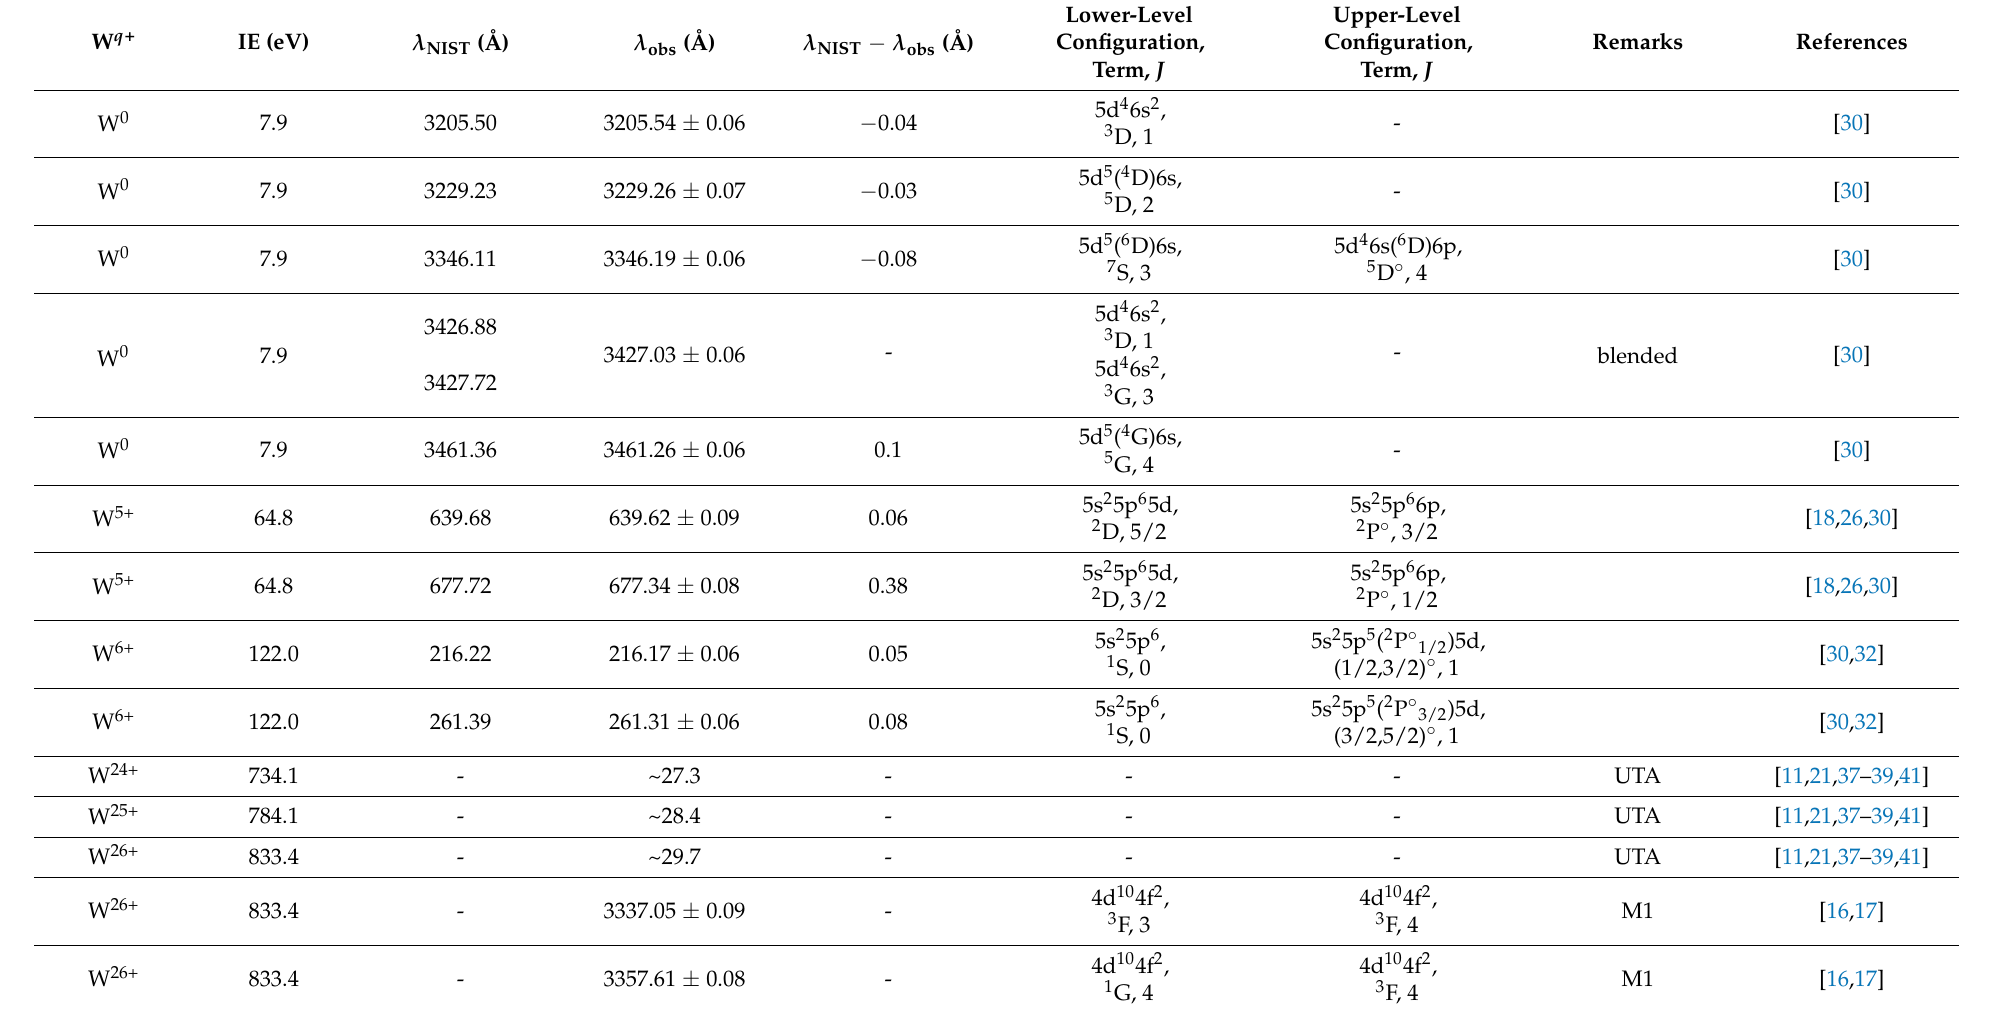
Table 1. Wavelength list of W 0 , W 5+ , W 6+ , W 24+ –W 28+ , W 37+ , W 38+ , and W 41+ –W 46+ line emissions observed in this